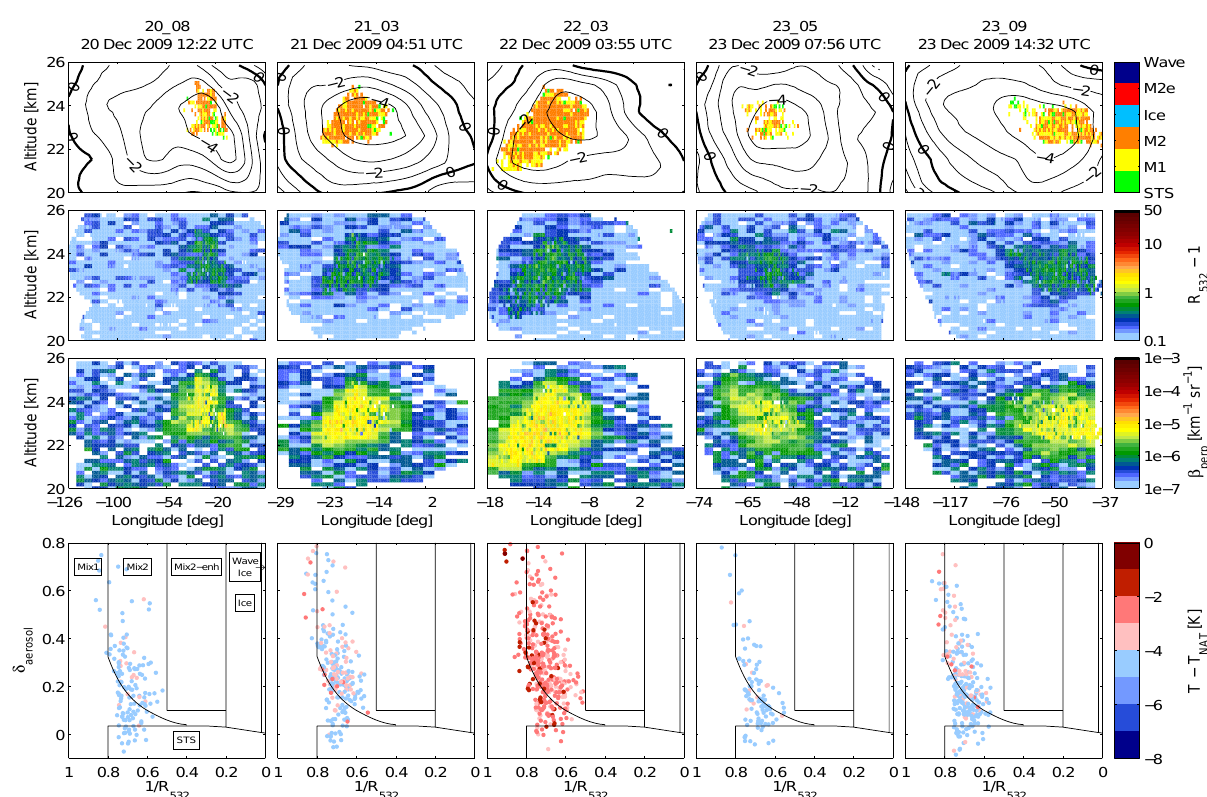
Fig. 10. As for Fig. 9, except that in this case the model results were calculated along trajectories with small-scale temperature fluctuations included, and γ 0 was set to 700K 3 .